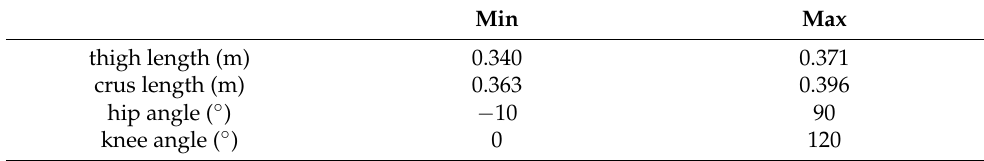
Table 1. D-H parameters.